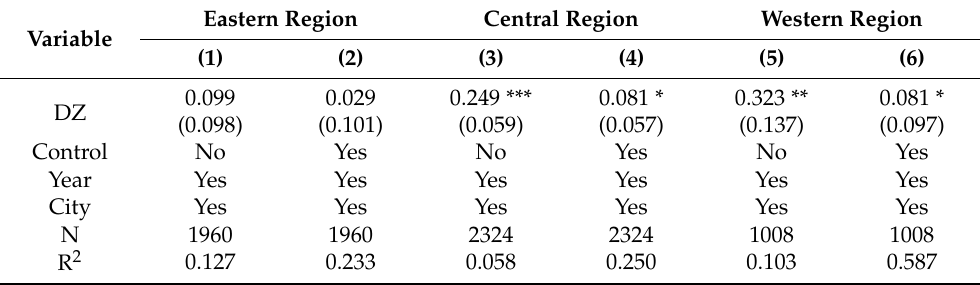
Table 5. Regional regression of the impact of DZs on population urbanization.